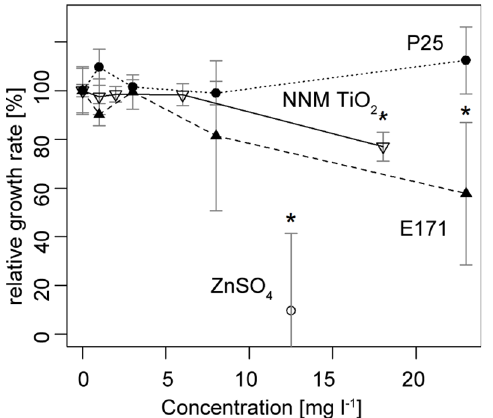
Fig 3. Relative growth rates of R . trifolii in YMB medium over a 32 h exposure assessed by optical density. R . trifolii growth rates were assessed in medium containing different actual concentrations and qualities of TiO 2 NPs (P25 filled diamond, E171 filled triangle, NNM TiO 2 inverted triangle, ZnSO 4 * 7H 2 O circle) during the 34 h (n = 4). Stars indicate significant (p < 0.05) differences from the control. Exponential growth curves are shown in S1